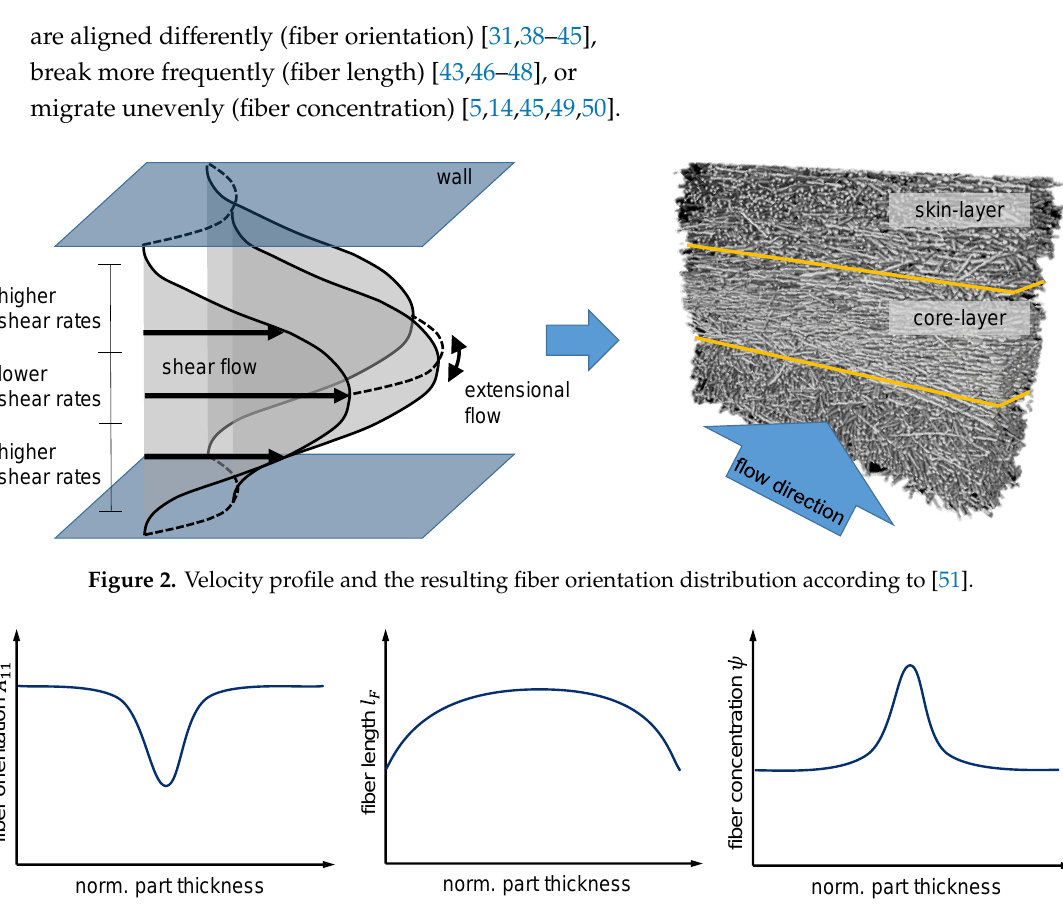
Figure 3. Locally varying fiber microstructure along the normalized part thickness (schematically).